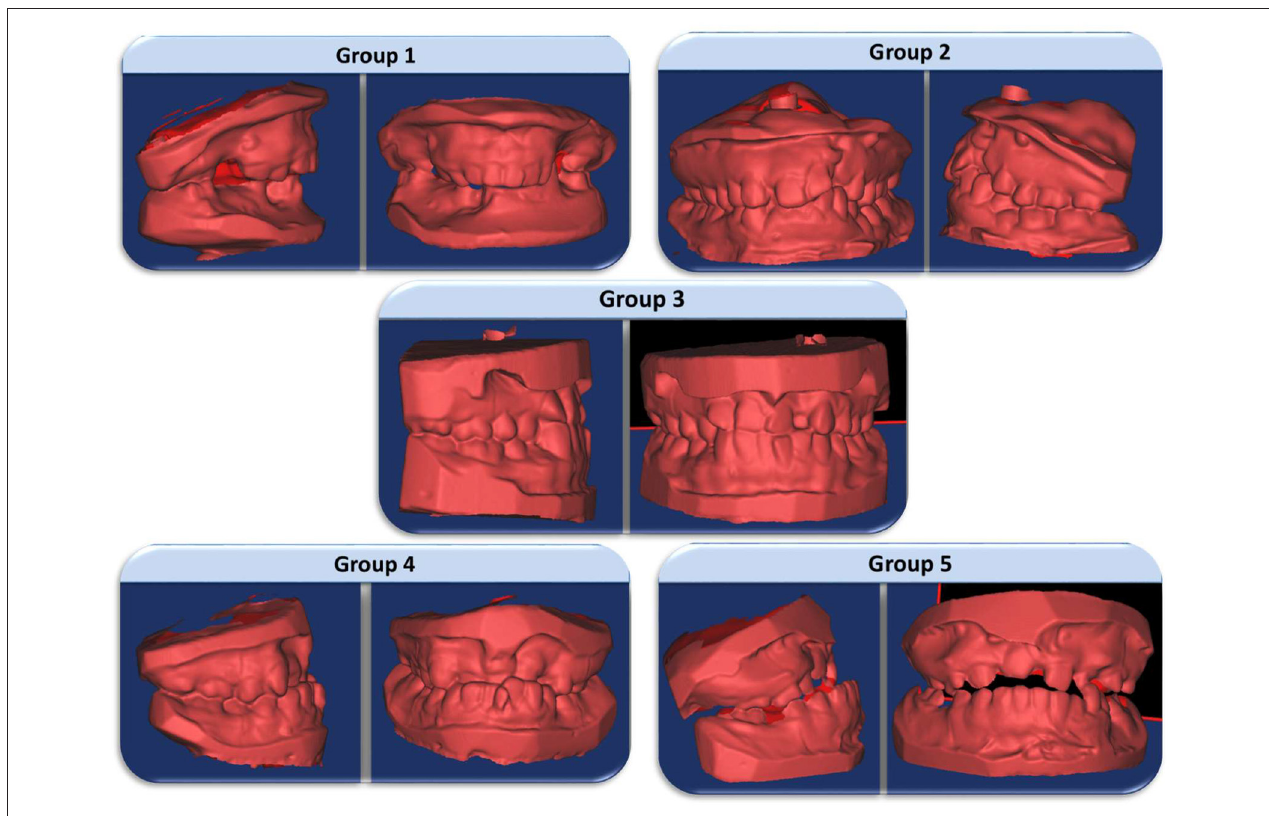
FIGURE 5 | Five groups of GY model picture in 3D format.